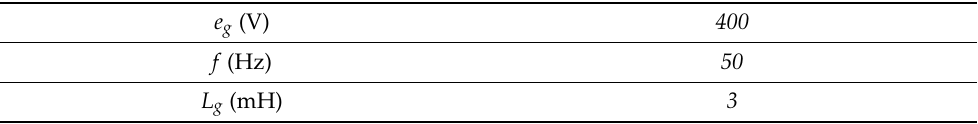
Table 4. Three-phase